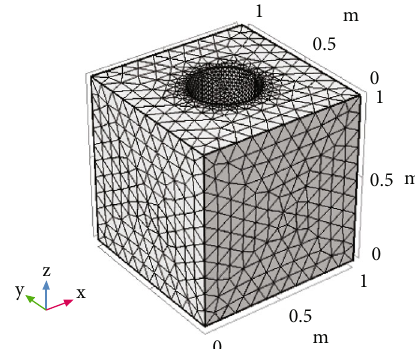
Figure 1: THM coupling fi nite element model of the coal rock during gas